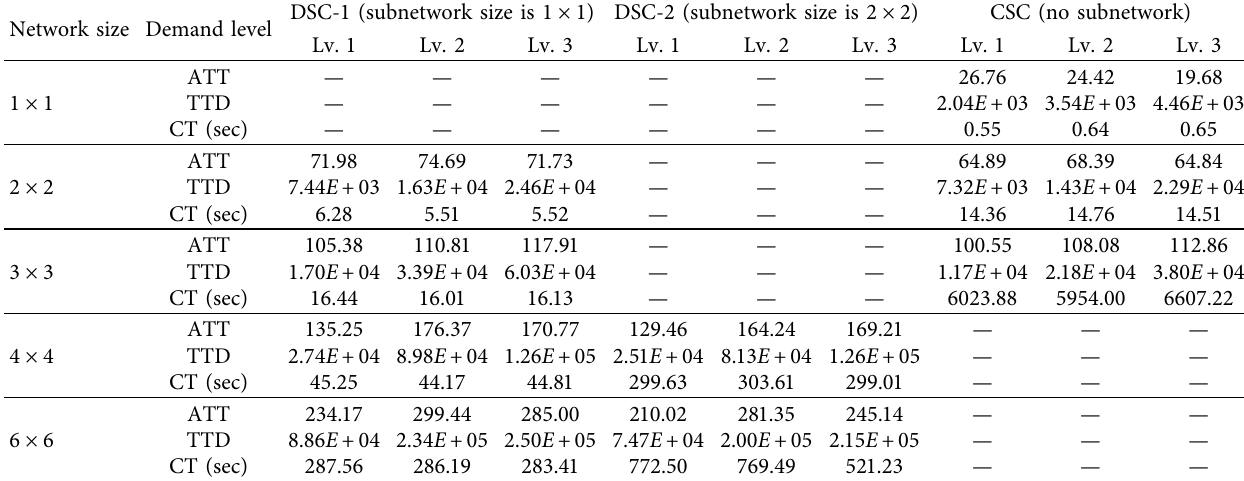
Table 5: Test results of scenario 5 (ATT and TTD are measured in time